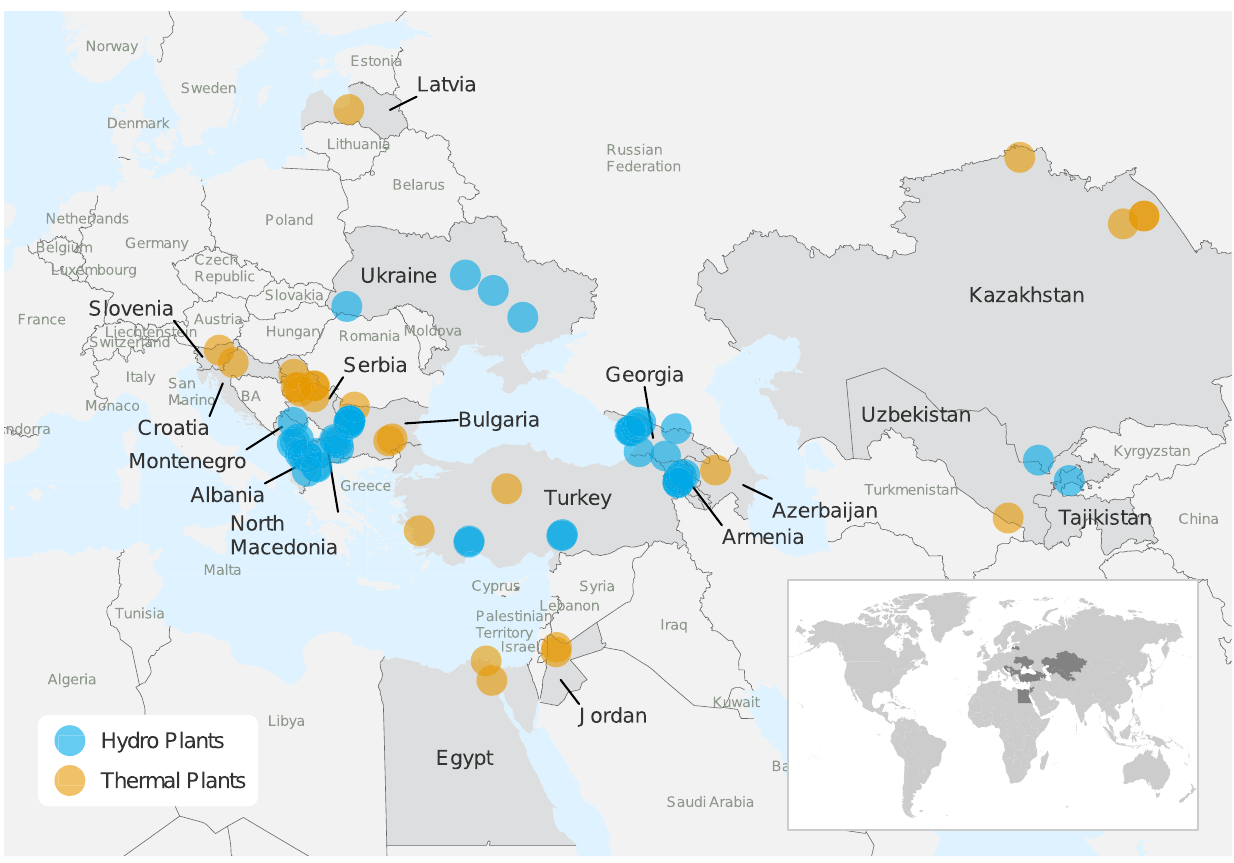
Fig. 2 Spatial distribution of power plants in EBRD ’ s current thermal and hydropower-generation portfolios. The thermal power plants are denoted with orange circles while the hydropower plants are denoted with blue